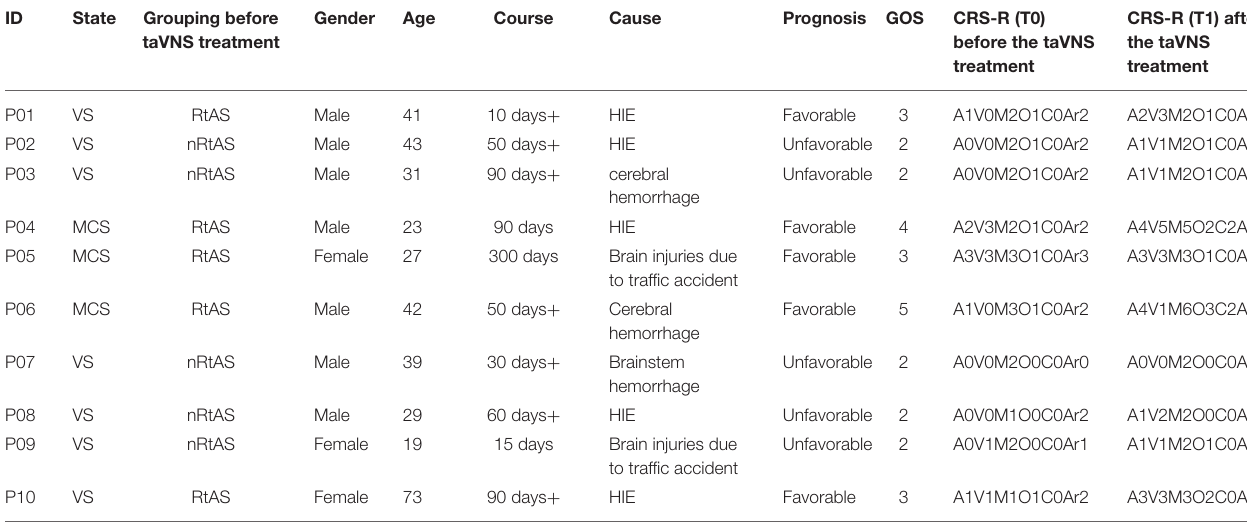
TABLE 1 | Patients’ demographics and clinical